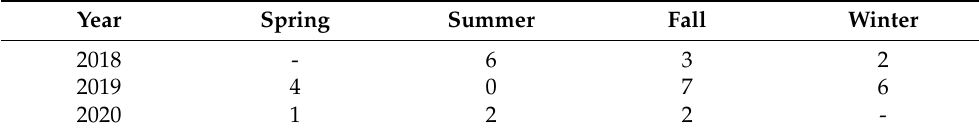
Each of the three fixed sites per creek were sampled for juvenile blue crabs with a Gee-style 6-mm square-mesh minnow trap that was deployed over 33 replicate sampling events between summer 2018 and autumn 2020 (Table 2). The only celestial season not sampled over this period was summer 2019. One sample site in each creek was located at or near the upstream extent of tidal influence while the other two sites were respectively located near the confluence of each creek with its higher-order estuary (Figure 1). Where a culvert was found, the two downstream sites were located either side of it (there were no culverts downstream of any of the study creeks). Mid-tide water depth at these sites ranged from 0.2 to 1.7 m and averaged 0.6 m (S.D. 0.3 m). Each trap was baited with frozen the sub-tidal/intertidal interface except for Webb Creek where traps were deployed in permanently sub-tidal habitats. For each replicate sampling event, all traps were set and then retrieved on the same respective days across all 24 sites. Trap catches were assumed to be independent among sites. Upon retrieval of each trap, blue crabs were counted, measured for carapace width (CW: mm), and released. Water temperature ( ◦ C), salinity (parts-per-thousand (ppt)), and dissolved oxygen (mg/L) were collected in conjunction with each trap deployment using a YSI Pro 2030 instrument (YSI Inc., Yellow Springs, OH, USA). Table 2. Number of replicate surveys conducted with each of ten consecutive seasons between summer 2018 and fall 2020 where juvenile blue crab Calinectes sapidus occupancy dynamics were studied across 24 fixed sampling sites in eight tidal creeks in coastal North Carolina